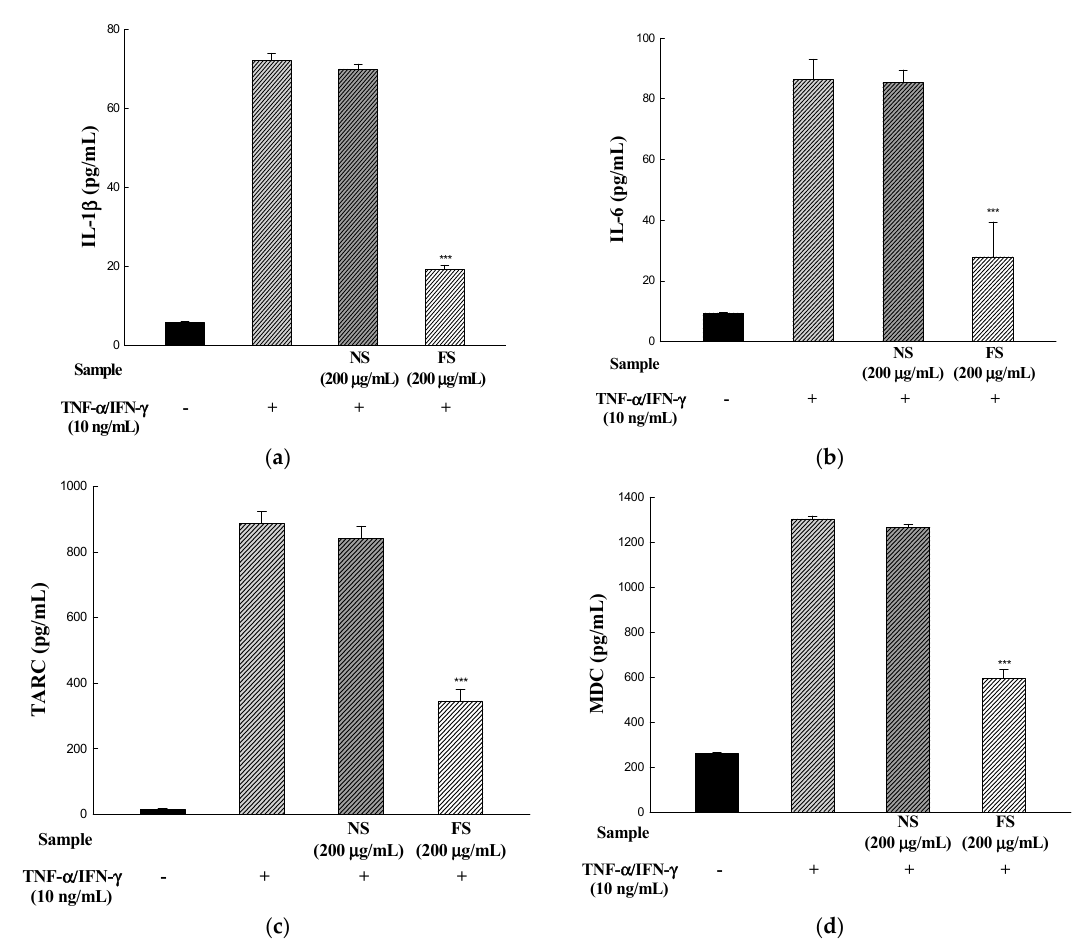
Figure 4. Effects of NS and FS extracts on TNF- α /IFN- γ -induced IL-1 β , IL-6, TARC, and MDC production in HaCaT cells. The production of IL-1 β ( a ); IL-6 ( b ); TARC ( c ); MDC ( d ) protein was measured by ELISA. Each bar represents the mean ± SD of triplicate determinations, n = 3; * p < 0.05, ** p < 0.01, *** p < 0.001 vs. TNF- α /IFN- γ treatment alone. +, TNF- α /IFN- γ treatment; − , TNF- α /IFN- γ untreated.